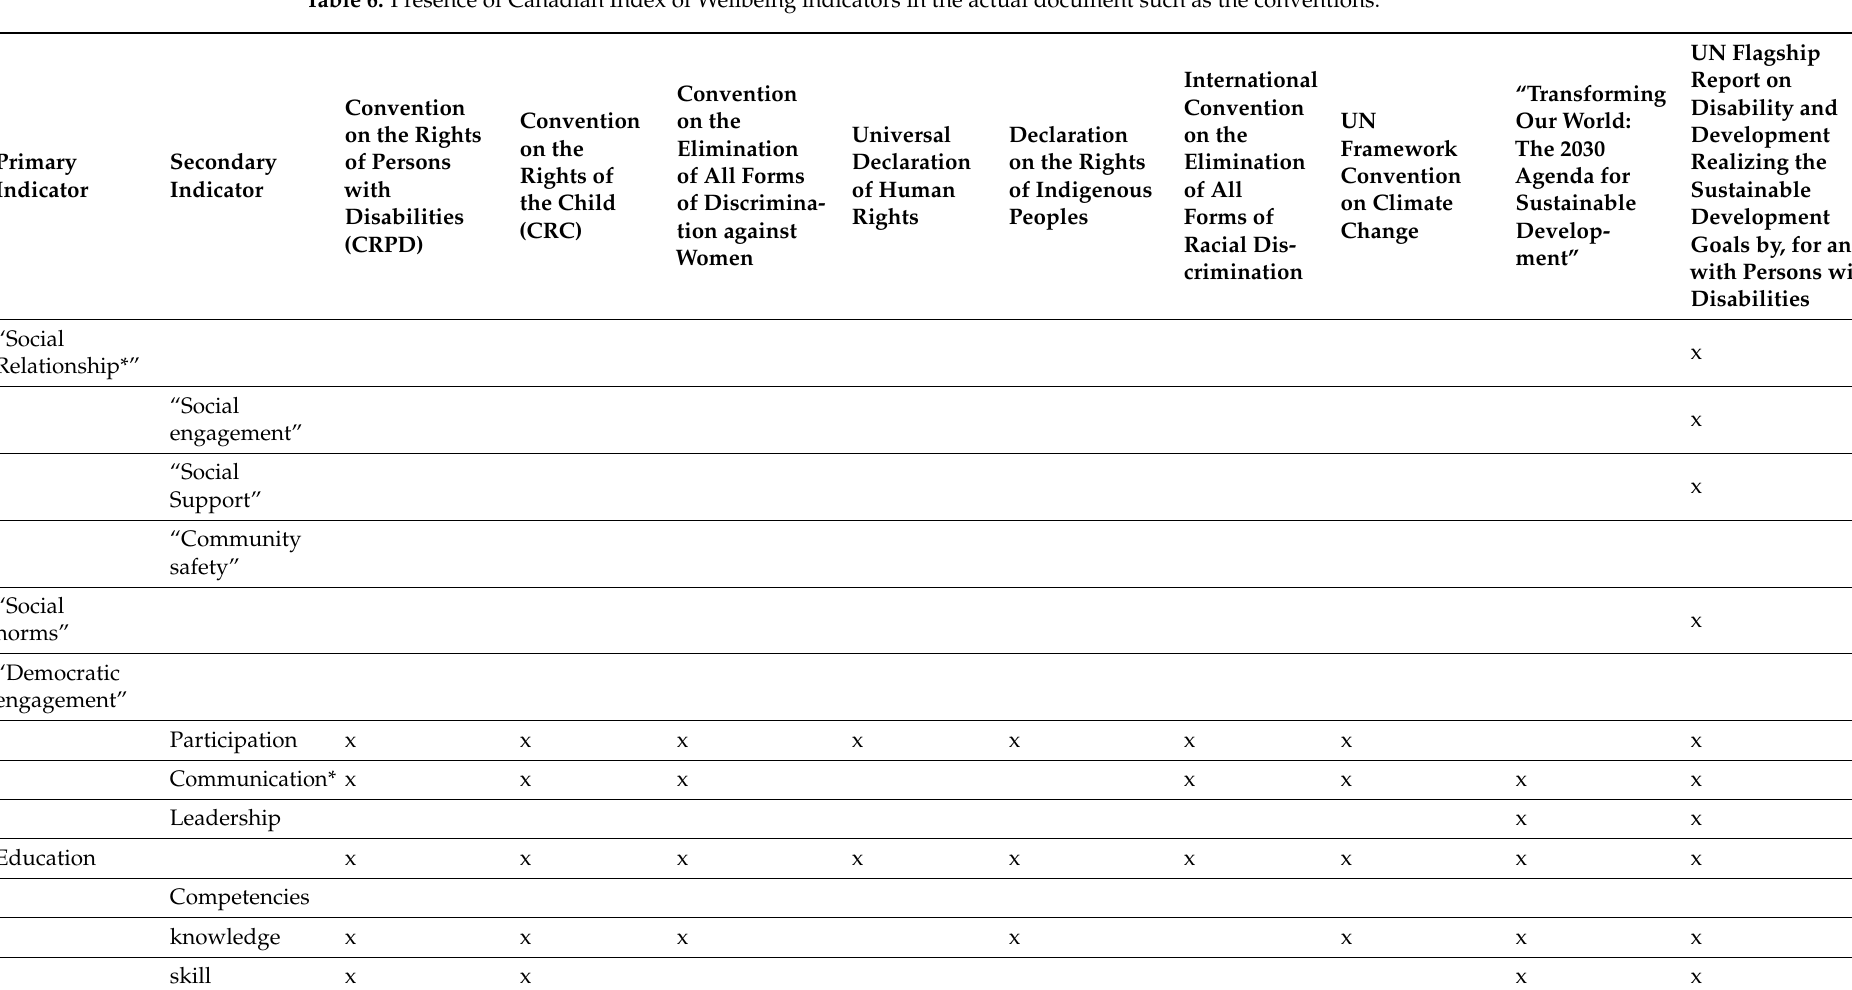
Table 6. Presence of Canadian Index of Wellbeing indicators in the actual document such as the